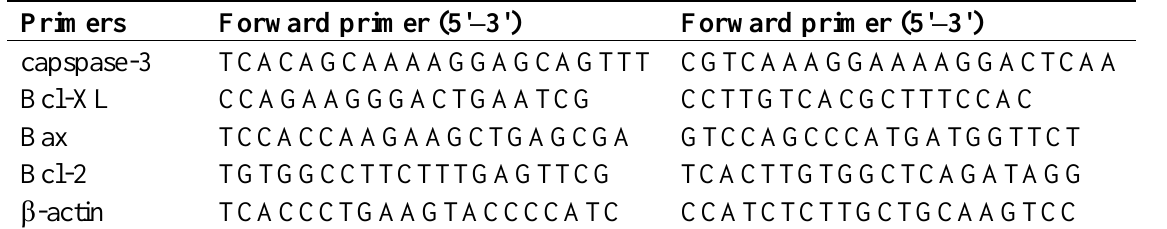
Table 1. The sequences of primers used in